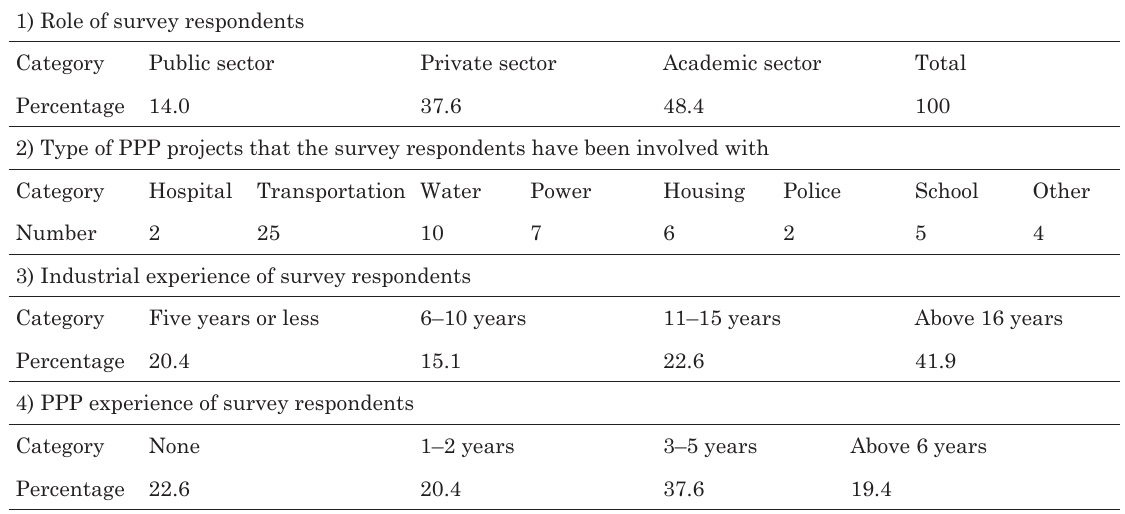
table 1. general Information about the Delphi survey respondents (round